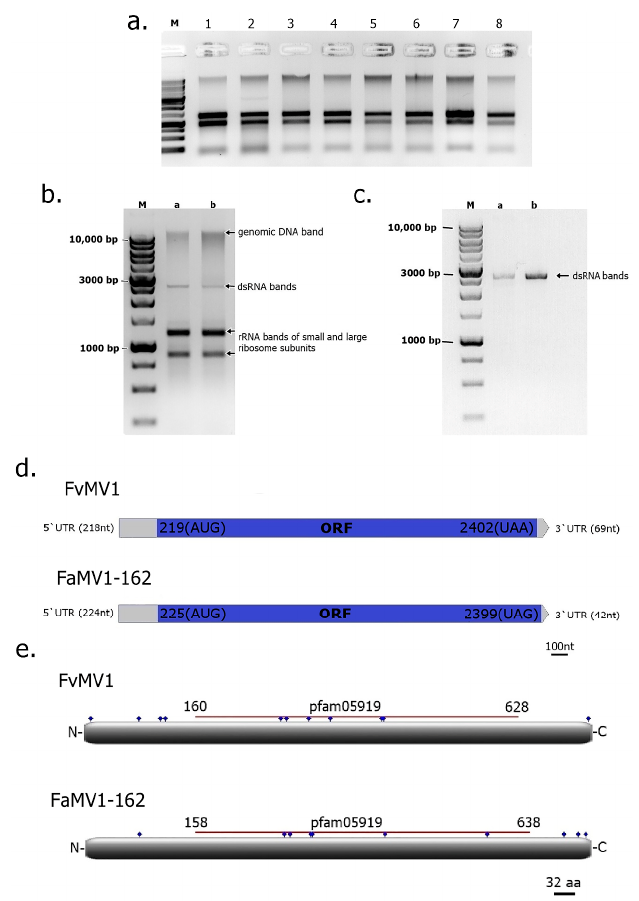
Figure 2. Molecular characterization of Fusarium verticillioides mitovirus 1 (FvMV1) and Fusarium andiyazi mitovirus 1 strain 162 (FaMV1-62). ( a ) Representative Agarose gel electrophoresis (0.8% w / v in bu ff er TAE) of chromatography on cellulose extracts prepared from monosporic cultures of fungal strains for the identification of dsRNA mycoviruses. Lane M: DNA molecular weight marker (1Kbp, NZYDNA Ladder III, NZYTech ® Paço do Lumiar, Lisboa, Portugal); lane 2: F. verticillioides isolate FvSec505; lanes 1 and 3 through 8: other Fusarium isolates from survey. ( b ) Agarose gel electrophoresis (0.8% w / v in bu ff er TAE) of chromatography on cellulose extracts from Fusarium andiyazi strain 162 (lane a) and Fusarium verticillioides strain Sec505 (lane b) showing dsRNA bands indicative of mycoviruses infection. ( c ) Agarose gel electrophoresis of the dsRNA bands identified in F. andiyazi strain 162 (lane a), and F. verticillioides strain Sec505 (lane b) after treatment with DNase and S1 Nuclease; as observed, both bands resisted digestion confirming their dsRNA nature. Lane M: DNA molecular weight marker (1Kbp, NZYDNA Ladder III, NZYTech ® , Paço do Lumiar, Lisboa, Portugal). Gels were stained with ethidium bromide and nucleic acids visualized and photographed under UV light using a transilluminator (EC3 Imaging System—UVP, LLC). ( d ) Schematic representation of the genomes of FvMV1 and FaMV1-162. The blue rectangles represent the single ORF (5 (cid:48) to 3 (cid:48) sense) identified in each mycovirus. Start and Stop codons are noted in parentheses, and numbers represent their positions in the mycovirus sequenced genome. The grey rectangles represent the 5 (cid:48) - and 3 (cid:48) -untranslated regions (UTR) with their lengths indicated in parenthesis. Scale bar is drawn in nucleotide unit (nt). ( e ) Schematic representation of predicted RNA dependent RNA polymerase (RdRp) proteins encoded by FvMV1 and FaMV1-162. The gray box represents the full length predicted proteins from their amino-terminus (N-) to the carboxyl-terminus (-C). Blue dots indicate the positions of UGA-encoded tryptophan. The dark-red line drawn above the gray rectangles indicates the position (numbers indicate the aa position) of the conserved domain of the mitoviral RdRp Superfamily (pfam05919). Scale bar is drawn in amino acid unit